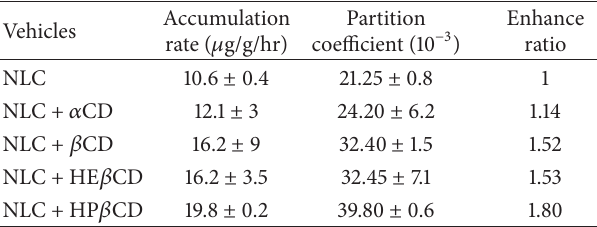
Table1:Effectofcyclodextrins(CD)oncornealluteinaccumulation in combination with NLC ∗